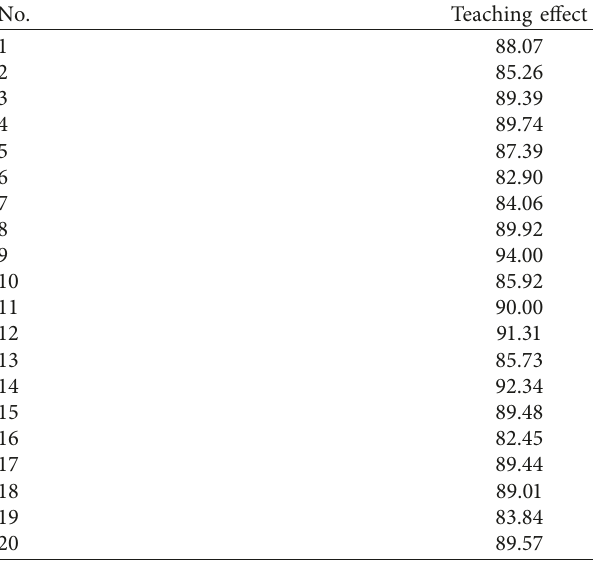
Table 2: Multimedia popular music teaching effect.